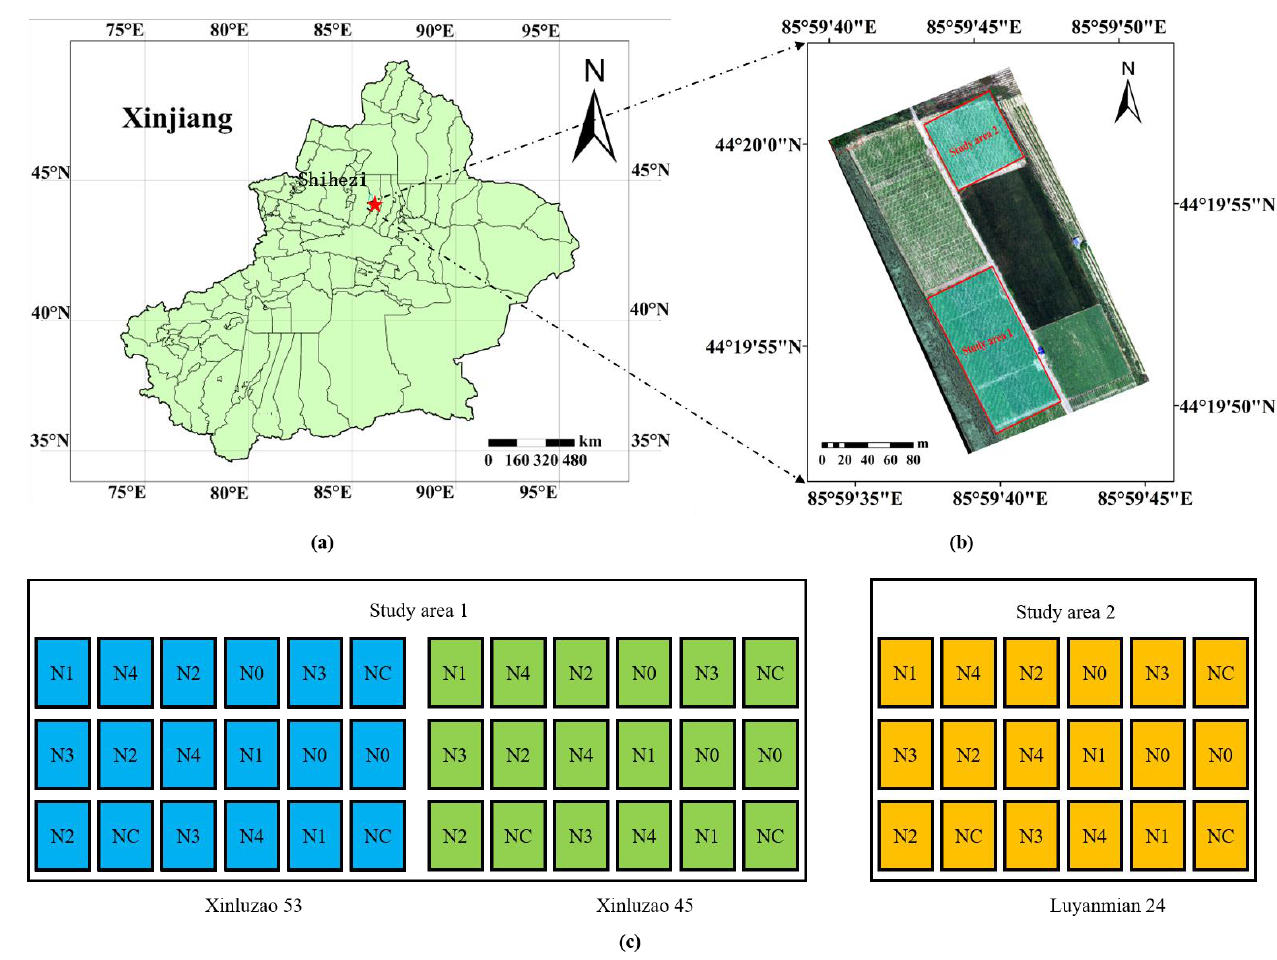
Figure 1. Study area survey: ( a ) location of study site; ( b ) study area1 plant Xinluzao 53 and Xinluzao 43, study area2 plant Luyanmian 24; ( c ) the level of nitrogen fertilizer in each area. Note: N0 represents nitrogen application of 0 kg/hm 2 , N1 represents nitrogen application of 120 kg/hm 2 , N2 represents nitrogen application of 240 kg/hm 2 , NC represents nitrogen application of 360 kg/hm 2 , N3 represents nitrogen application of 480 kg/hm 2 , and N4 represents nitrogen application of 600 kg/hm 2 .